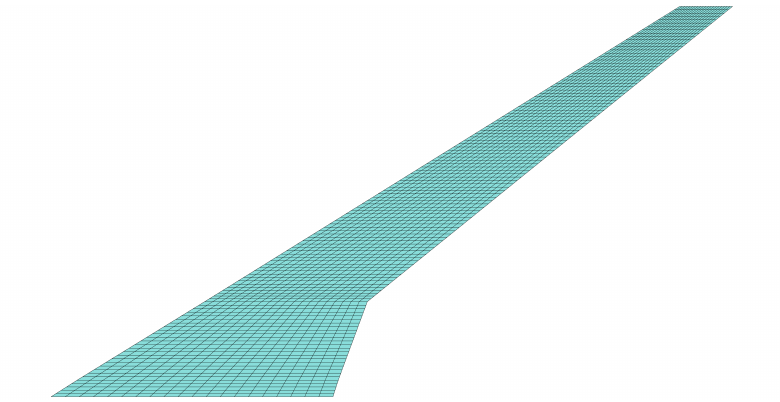
Figure 2. DLM aerodynamics model of the main case